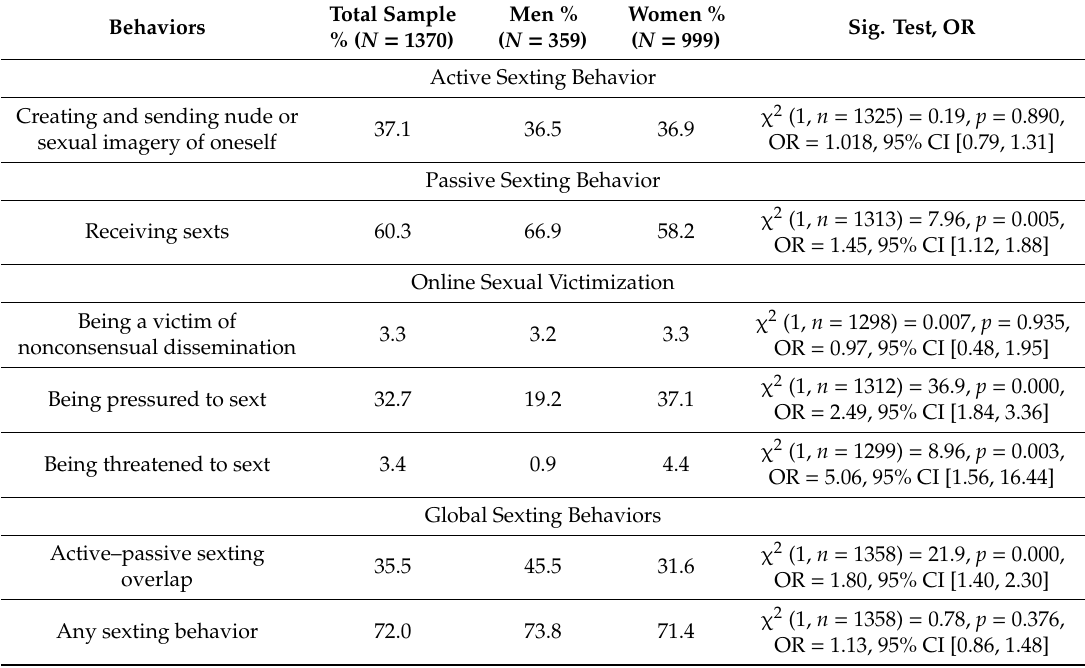
Table 2. Prevalence of sexting behaviors by